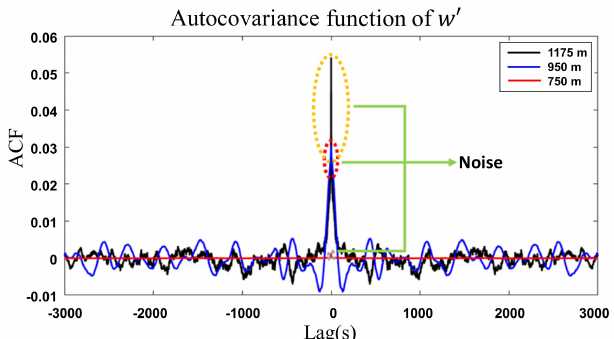
Figure 4. Autocovariance function (ACF) of w (cid:48) , obtained from Doppler lidar at three different heights on 19 May 2016 from 08:00– 09:00UTC in Granada.